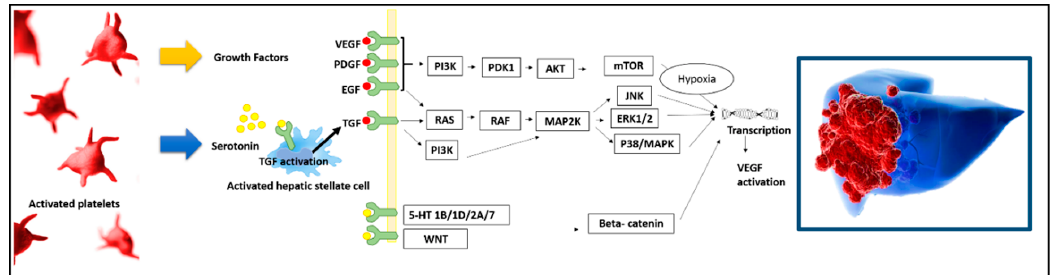
Figure 1. Molecular mechanisms connecting platelets and hepatocellular cancer (HCC), supporting tumor local progression.